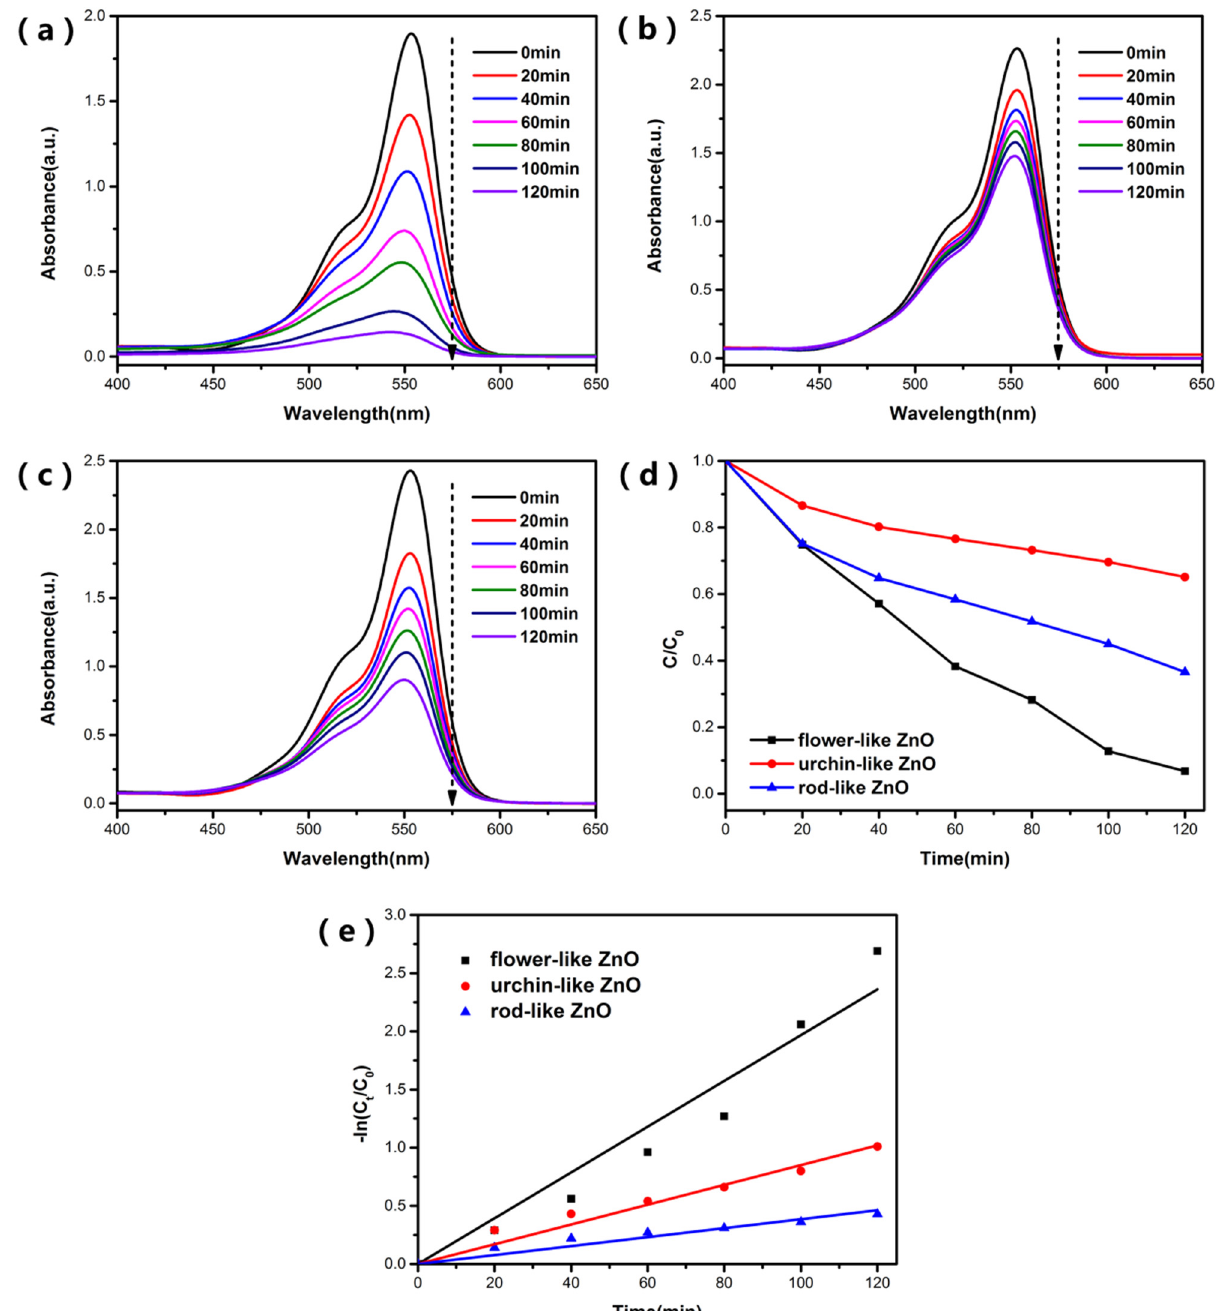
Figure 7: The UV - visible absorbance spectra of RhB during degradation by ( a ) fl ower - like ZnO, ( b ) urchin - like ZnO, and ( c ) rod - like ZnO. ( d ) Photocatalytic activities of the three samples evaluated by the degradation of RhB under simulated sunlight, and ( e ) fi tted curves with pseudo - fi rst - order kinetic model of samples under simulated